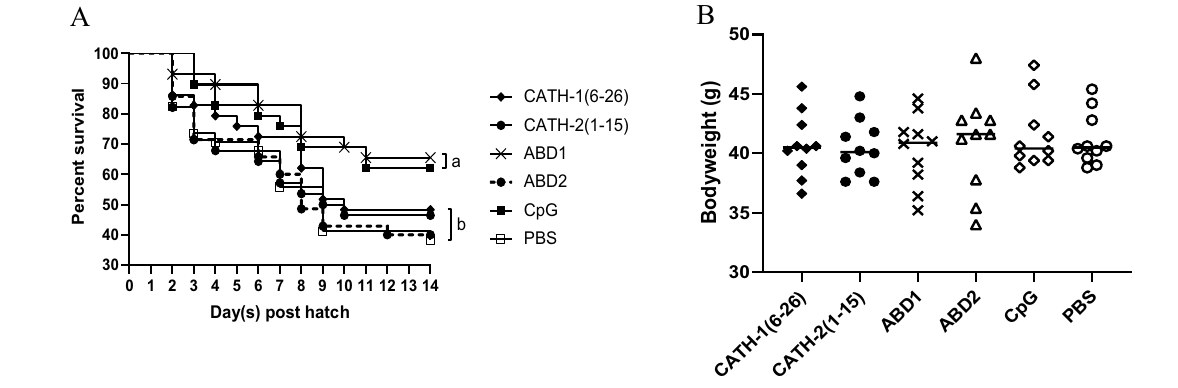
Figure 7. Survival proportions and day-old bodyweight. ( A ) Survival proportions of chickens following E. coli challenge (45 CFU/bird via navel route). The statistically significat difference between groups is represented by different letters (a or b). ( B ) Bodyweight of 1-day-old chicks was measured from 10 chicks per group before E. coli challenge.